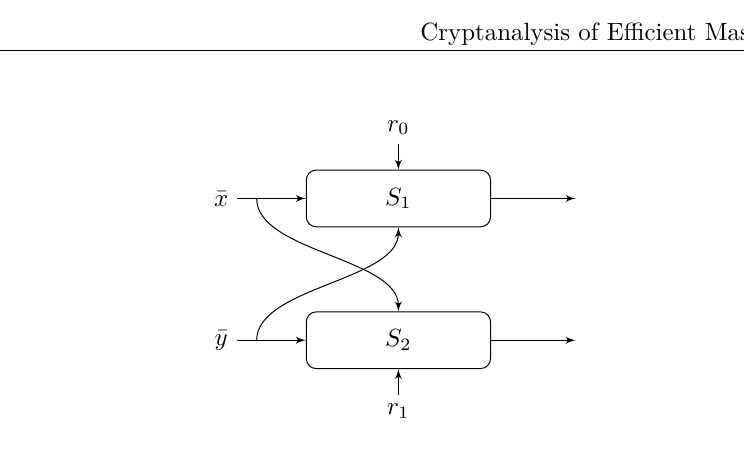
Figure 4: Two paired masked